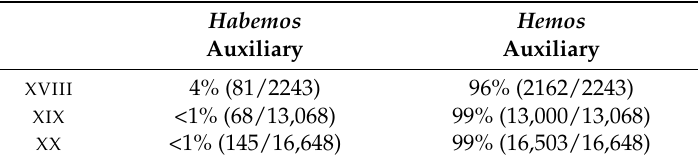
Table 2. Habemos vs. hemos as auxiliary